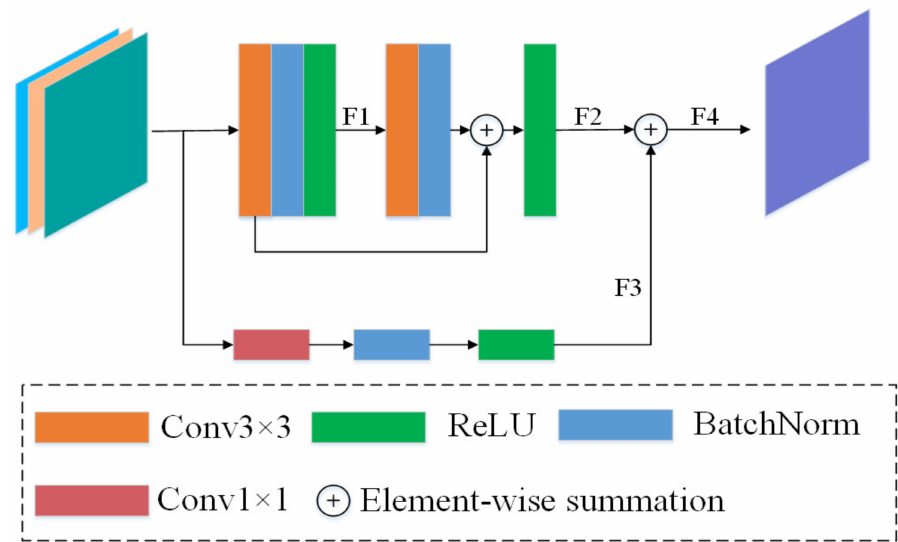
Figure 4. Refinement Residual Block (RRB). F 1– F 4 represent the feature maps that are output by different